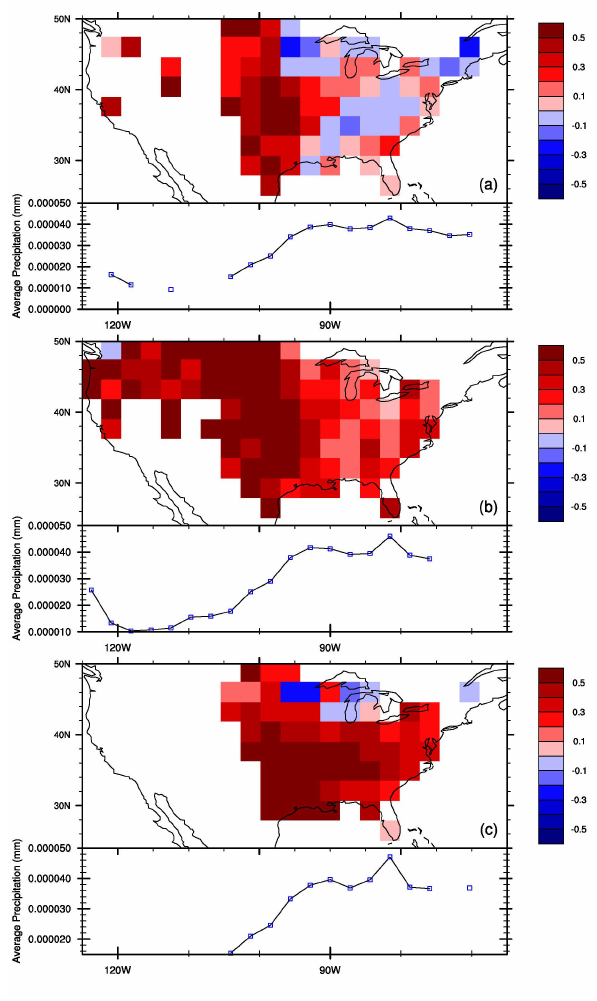
Fig. 10. Correlation coefficient between precipitation and yield for (a) maize, (b) spring wheat, and (c) soybean. The bottom half of each panel shows the longitudinal average precipitation (mm) dur- ing the growth period for each